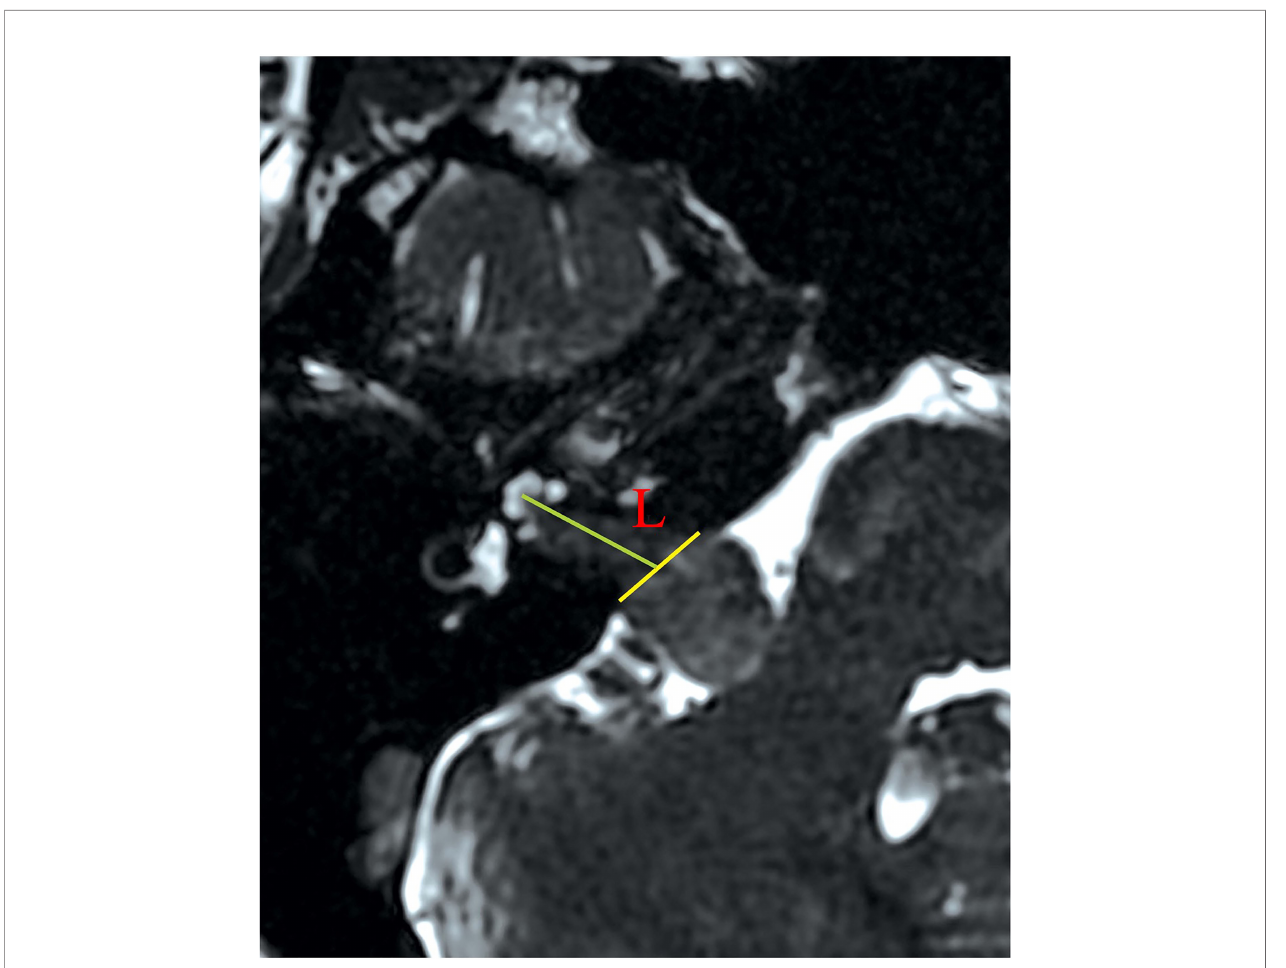
FIGURE 1 | Measurement of the absolute tumor extension into IAC. On FIESTA-C, the slice with the most lateral extension of tumor is selected for measurement. An auxiliary line (yellow) is drawn between the anterior and posterior lip of the porus acusticus. The length of absolute tumor extension (labeled as L) is de fi ned as the distance between the midpoint of the yellow line and the most lateral point of tumor extension. De fi ning the absolute extension of tumor in this way is different from assuming the extension of tumor as its projection on the posterior wall of IAC. The latter method appears ideal to pre-operatively de fi ne the length of the drilled posterior wall of IAC. However, the presence of tumor may erode the bony structure of the posterior wall of IAC, making delineation of the projection line dif fi cult on pre-operative imaging studies. FIESTA-C, heavily T2-weighted fast imaging employing steady-state acquisition with cycle